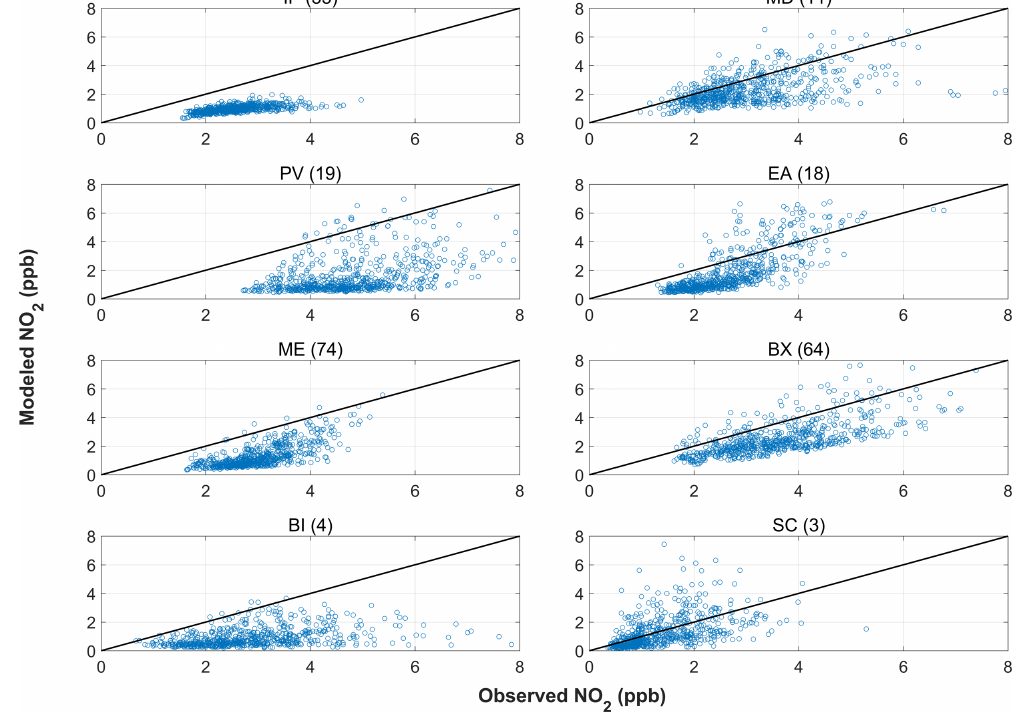
Figure 6. Scatterplots of modeled vs. observed surface afternoon (12:00–18:00UTC) mean NO 2 mixing ratios in eight European regions in summer 2010. The number of stations available for each region is reported in parentheses at the top of each panel. A definition of the regions is given in Fig.